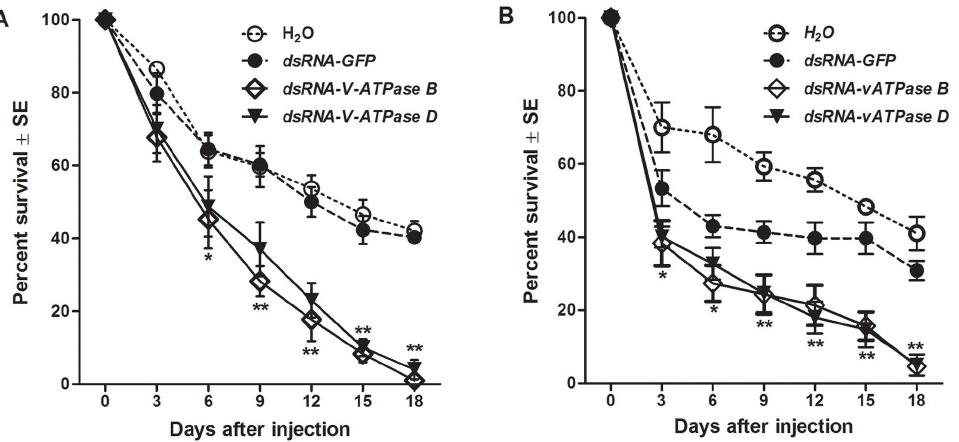
Figure 4. Peregrinusmaidis mortality after injection with dsRNA. Fifth-stage nymphs were injected with 40 nL H 2 O or 40 nL (200 ng) of dsRNA ( V-ATPase B , V-ATPase D or GFP ). The experiment was performed twice, i.e. , two independent biological replicates ( A and B ). Each point represents the mean 6 standard error of the mean of n = three experimental replicates with 20 insects per replicate-cage monitored repeatedly over time. The single asterisk (*) indicates that only dsRNA-V-ATPase B treatment mean differs significantly ( P , 0.05) from either control group mean; a double asterisk (**) signifies that both the means of dsRNA-V-ATPase B and D differ significantly ( P , 0.05) from that of the controls.